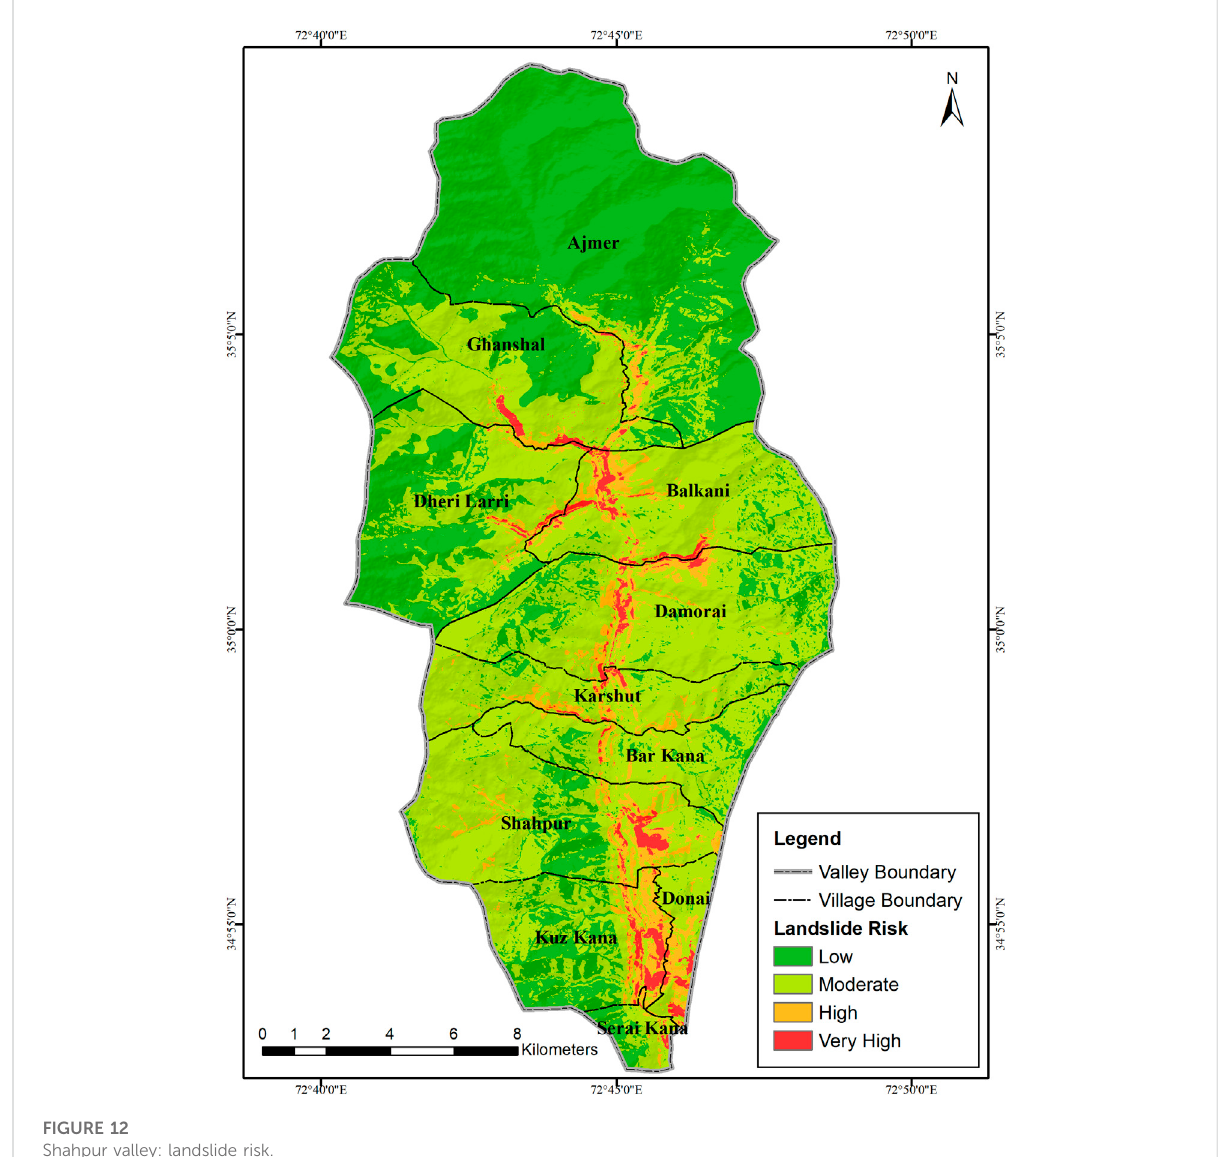
FIGURE 12 Shahpur valley: landslide